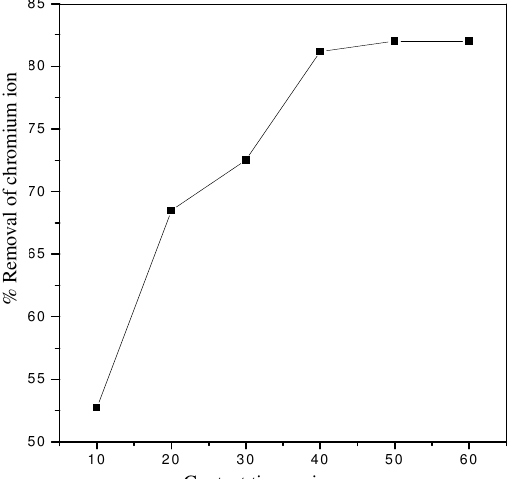
Figure 1 . Effect of contact time on the removal of chromium ion by PDC [Cr]=20 mg/L, pH=6.5; Dose=50 mg/50